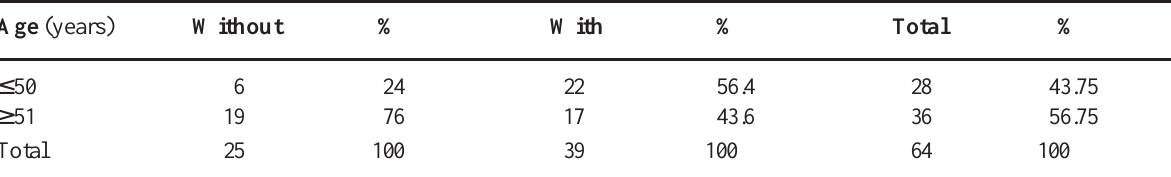
Table 1 – Distribution of patients with and without sexual activity, by age group.